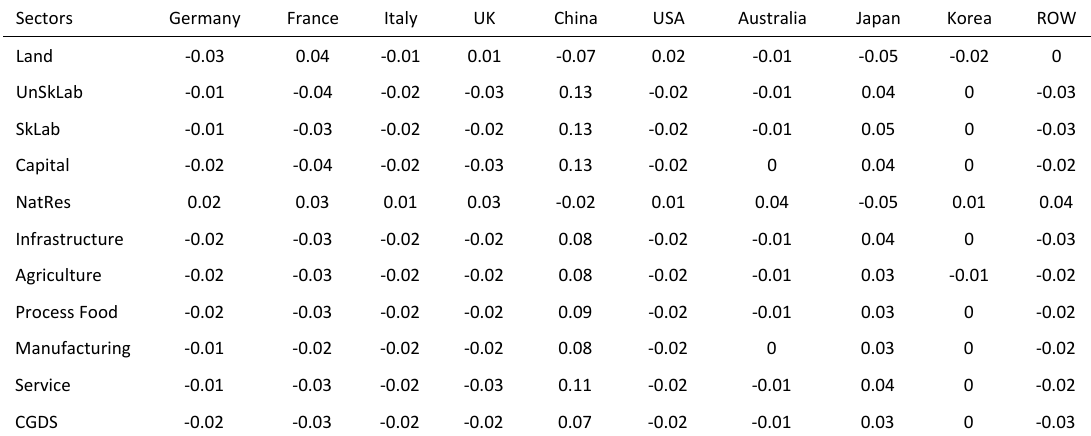
Table 8: Change in market price by sector (%)